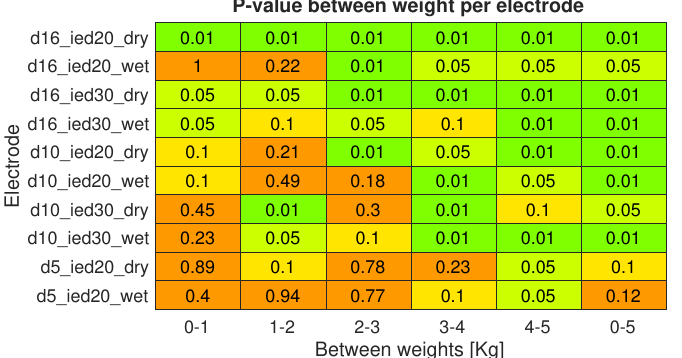
Figure 15. Mean envelope of each electrode obtained for all subjects, shown per load sample.